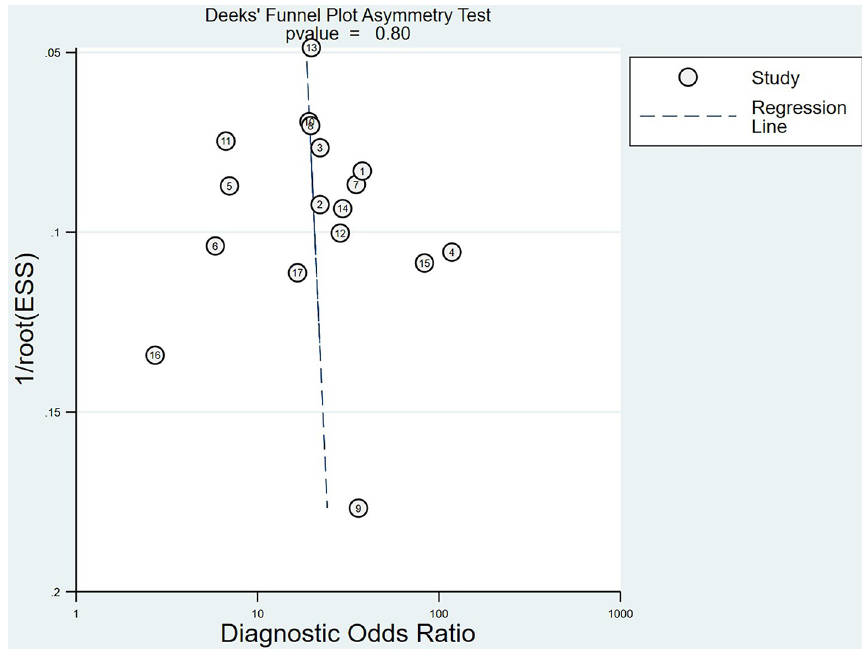
Fig 7. The results of Begger’s funnel plot of publication bias on the pooled OR. There is no publication bias observed.